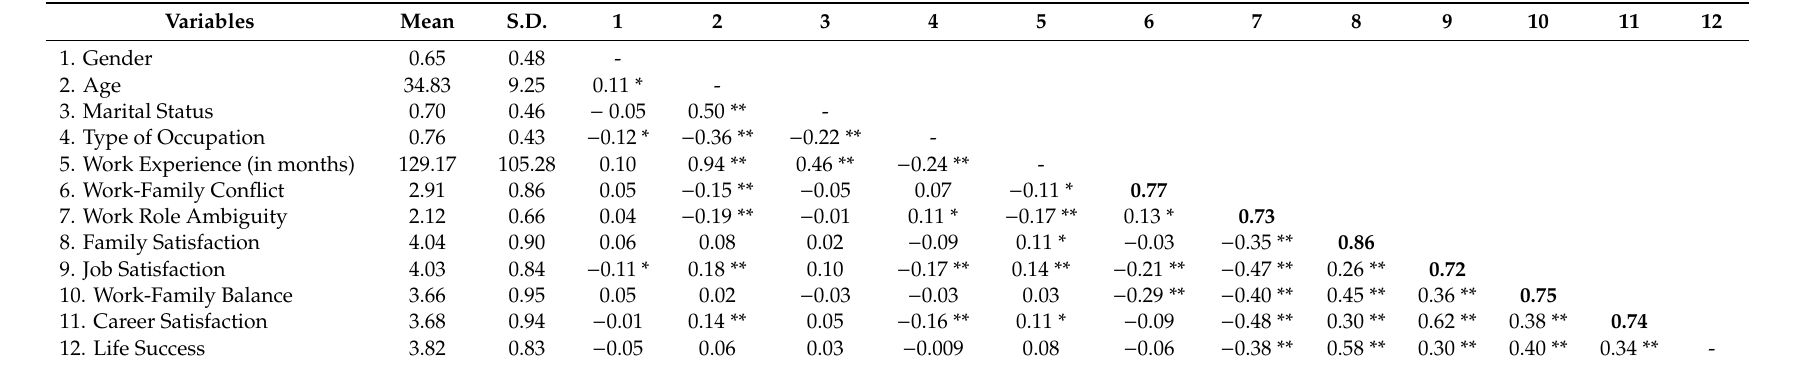
Table 1. Descriptive statistics, zero-order correlations and reliability values.